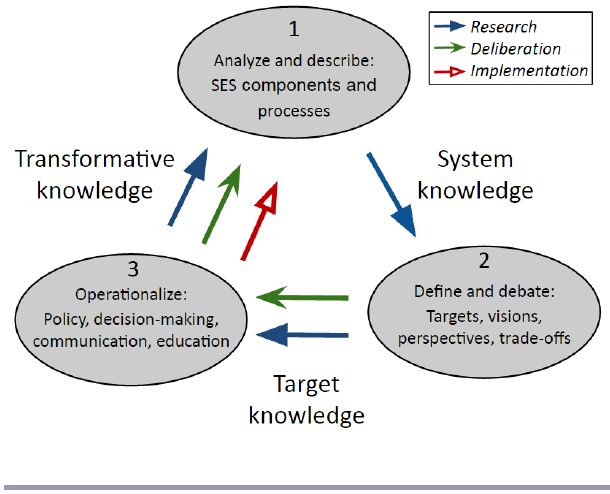
Fig. 1 . Conceptual interpretation of a circular